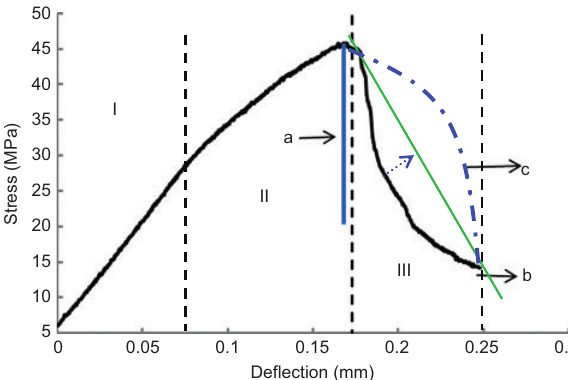
Figure 5 Typical load-defection plots tested by three-point